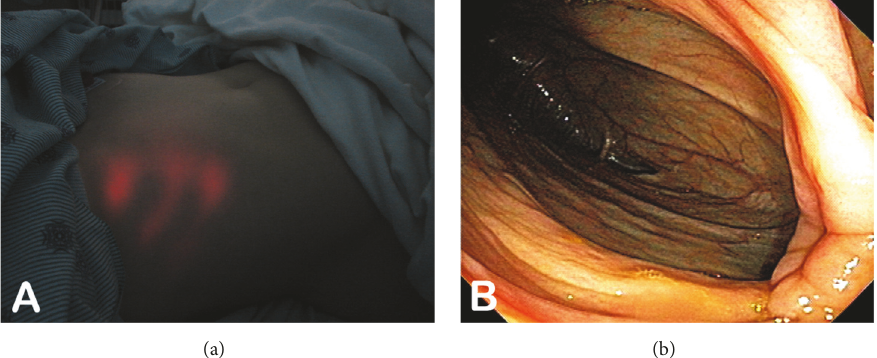
Figure 2: Images of a patient with gut malrotation, the cecum is located within the right upper quadrant, below the liver. Trans-abdominal light illumination can be observed within the right upper quadrant (a). The hepatic hue is observed during colonoscopy